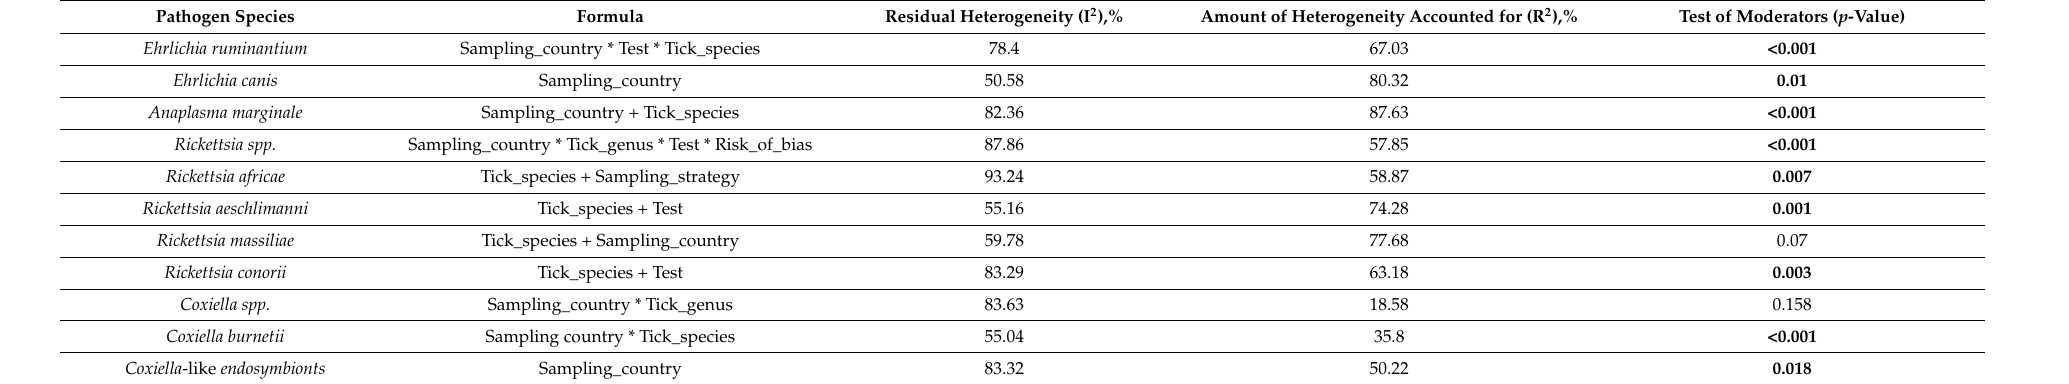
Table 6. Meta-regression on the molecular prevalence of Anaplasmataceae , Rickettsiaceae and Coxiellaceae in African